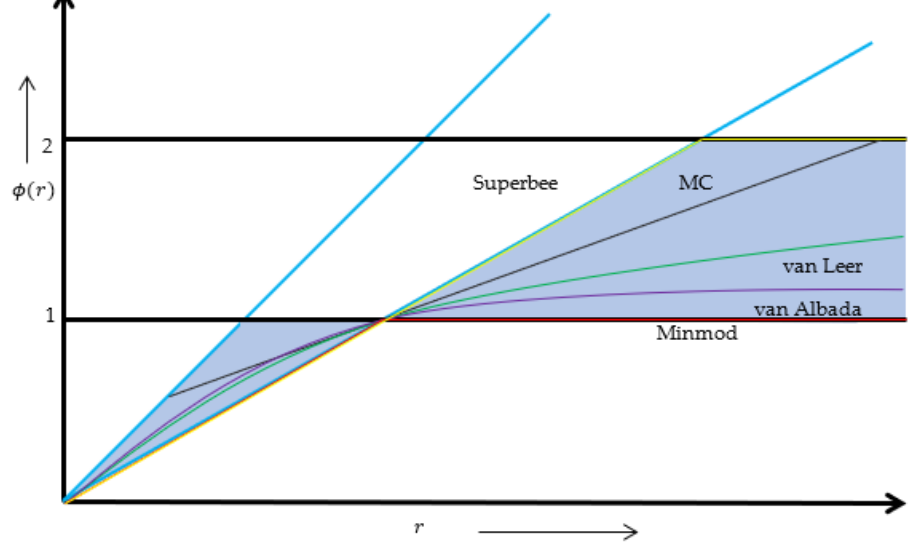
Figure 11. Sweby diagram for limiter functions for a higher order TVD scheme [67].